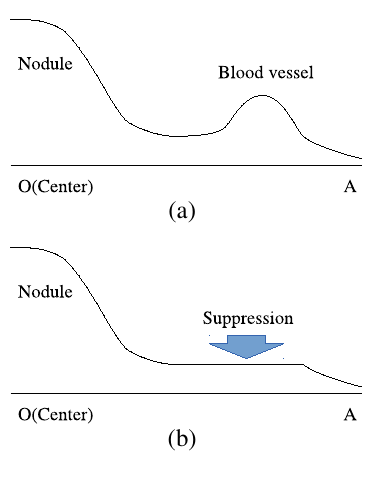
Figure 3. Effect of a radial suppression. ( a ) example of an intensity profile; ( b ) suppression result.